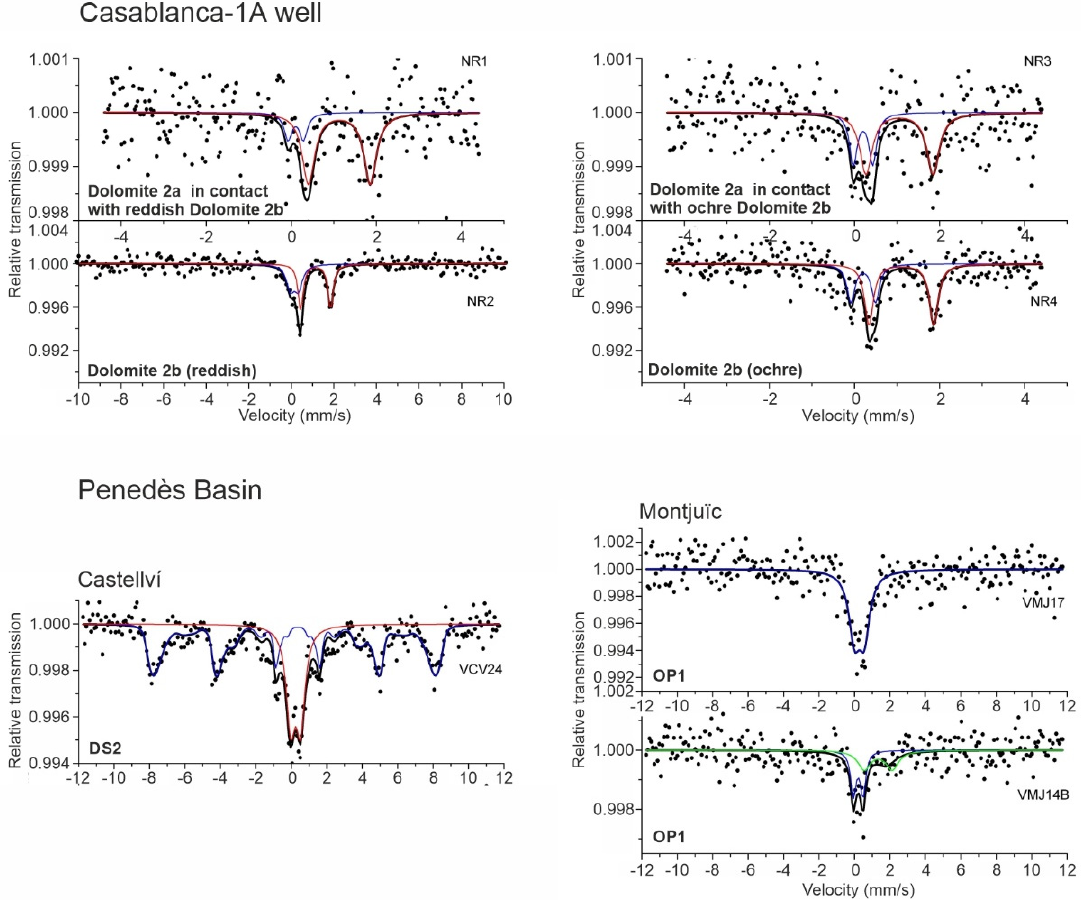
Figure 10. Mössbauer spectra of Dolomite 2a (in contact with red or ochre Dolomite 2b) and Dolomite 2b in the Casablanca 1A oil well, as well as dolomite DS2 in Castellví outcrop and the orange fill made of pisoids in Montjuïc outcrop from the Penedès Basin (OP1). Table 3. Hyperfine parameters of Mössbauer spectra. Γ (mm/s): full width at half maximum peak; δ Fe (mm/s): isomer shift;